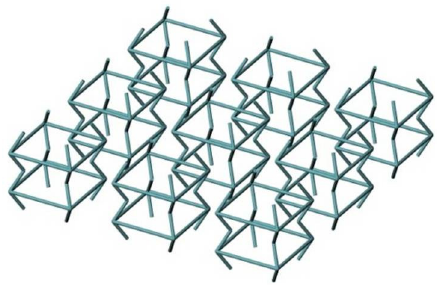
Figure 2. Example of a lattice ‐ type core structure based on a three ‐ dimensional auxetic unit cell.